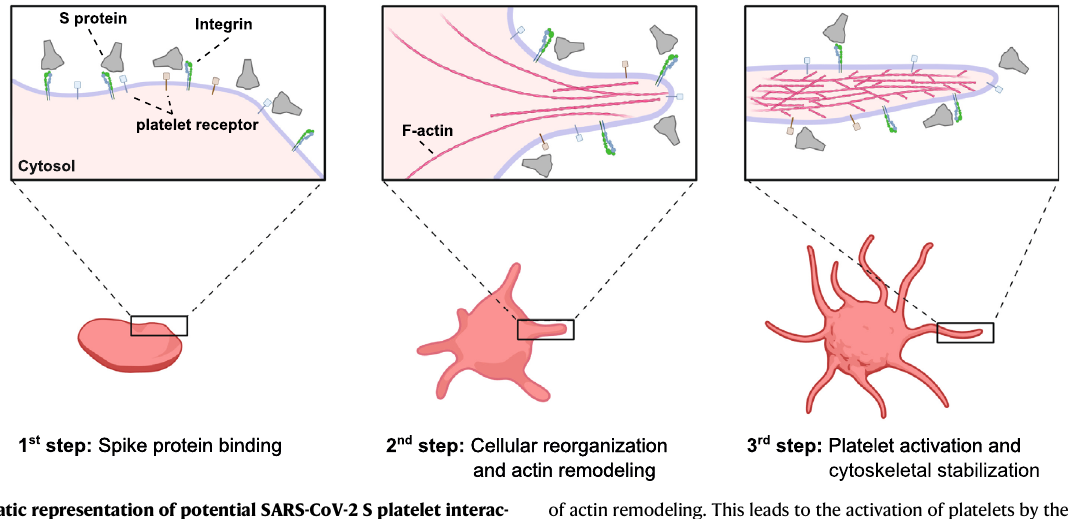
of actin remodeling. This leads to the activation of platelets by the formation of fi lopodia and the stabilization of the cytoskeleton network. The scheme was cre- ated with